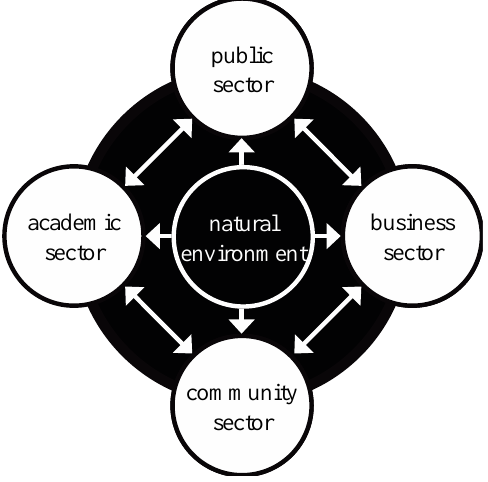
Figure 5. “Quadruple helix” plus environment, adapted from Gouvea et al . [30].